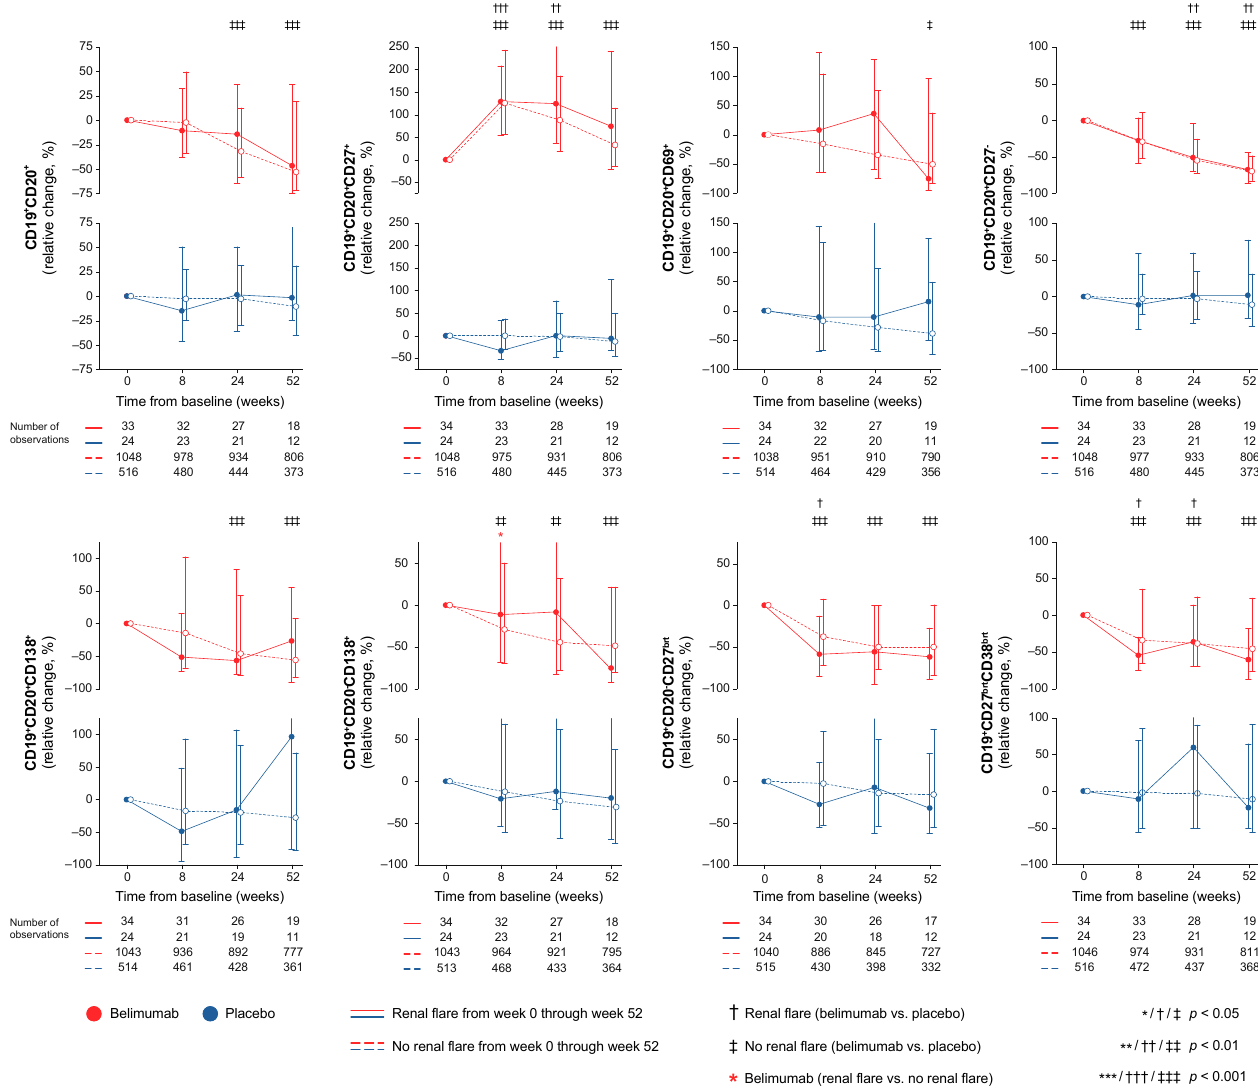
Figure 1. B cell alterations in relation to renal flares. The graphs delineate relative to baseline percentage changes in selected B cell and peripheral plasma cell subsets in patients who developed at least one renal flare during the study period (continuous lines) and patients who did not (dashed lines). Comparisons between patients who flared and patients who did not were conducted using multivariable logistic regression analysis to account for potential confounders and are illustrated for patients who received non-biological standard therapy plus belimumab (red lines) and patients who received non-biological standard therapy alone (blue lines). Comparisons between treatment arms were conducted using non-parametrical Mann–Whitney U tests. Whiskers indicate the interquartile range of distributions. The number of patients with available data at each time point is indicated for each patient subgroup.